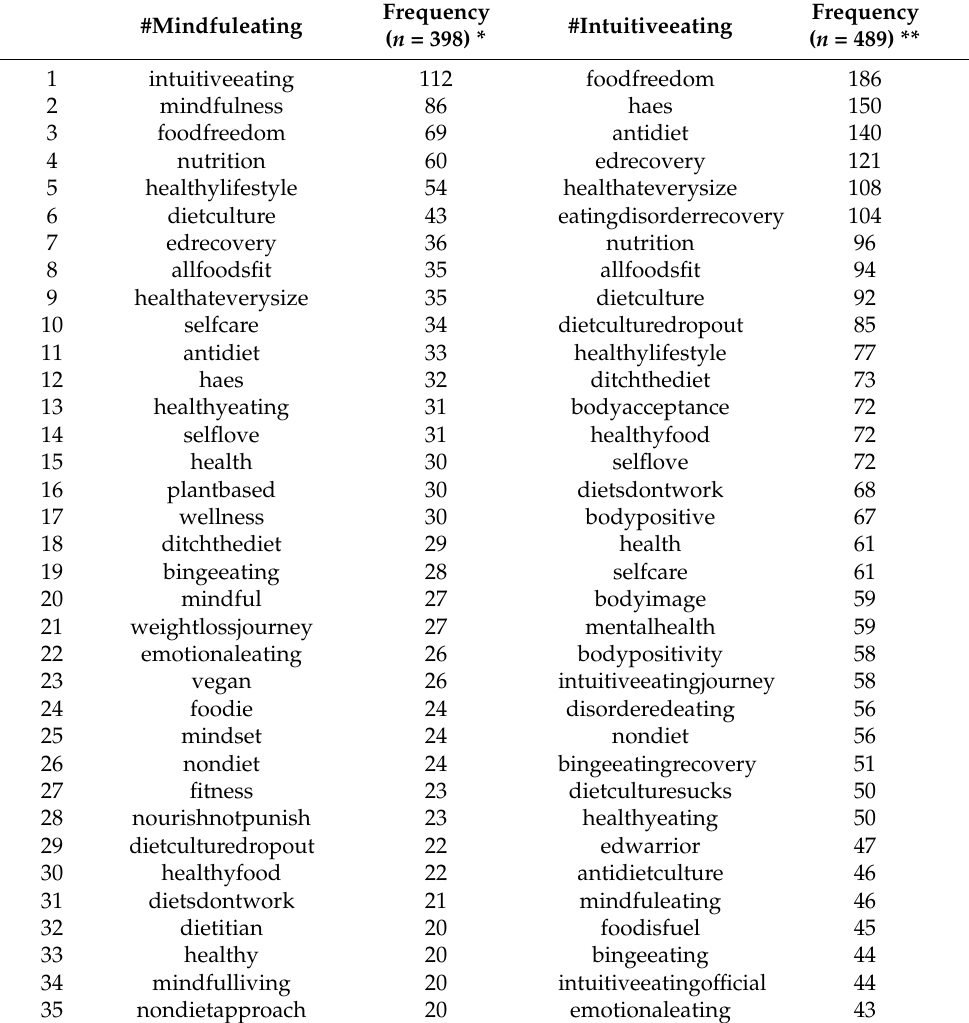
Table 3. Thirty-five most common concurrently assigned hashtags in content categorized under #mindfuleating and #intuitiveeating on Instagram, by